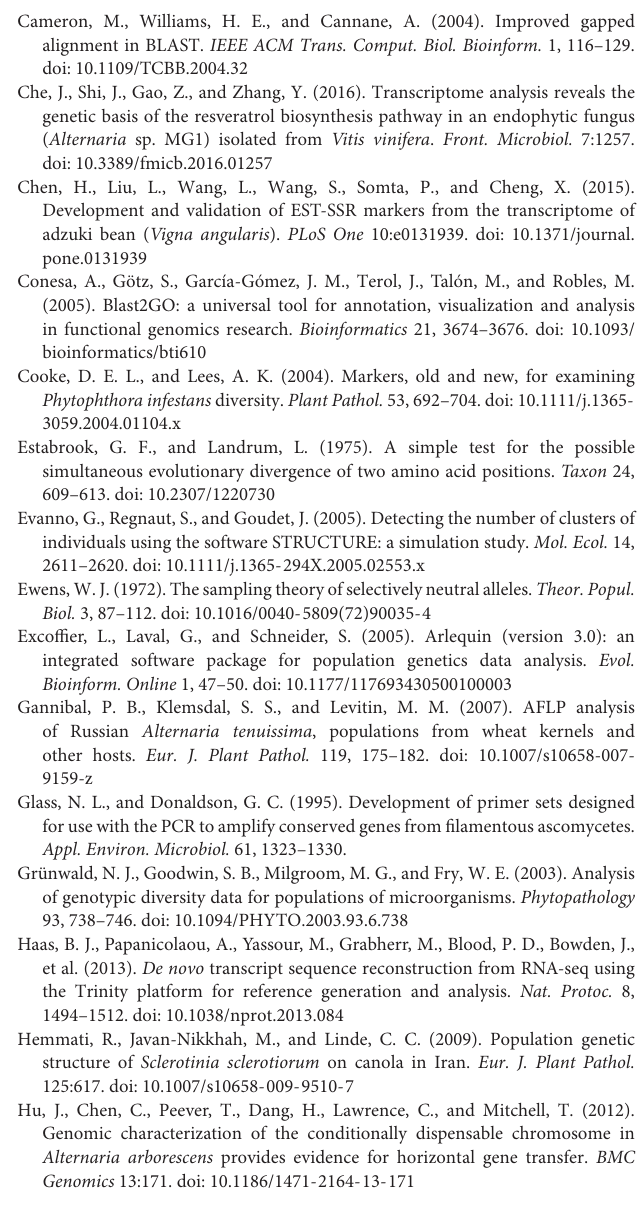
FIGURE S2 | The estimated Delta K (K) for number of clusters ranging from 2 to 10 in STRUCTURE analysis. FIGURE S3 | Plot of isolation by distance for the entire population, the geographic region Northern China, the geographic region Northeastern China, and the geographic region Eastern China. TABLE S1 | Isolates of Alternaria tenuissima comprising four different geographic regions in China. TABLE S2 | Transcriptome reads and assembled contig information for Alternaria tenuissima . TABLE S3 | The SSR of unigene annotations in KOG and GO database, and the pathway of KEGG orthology. TABLE S4 | Pairwise F ST calculated with Arlequin (assessed after 1000